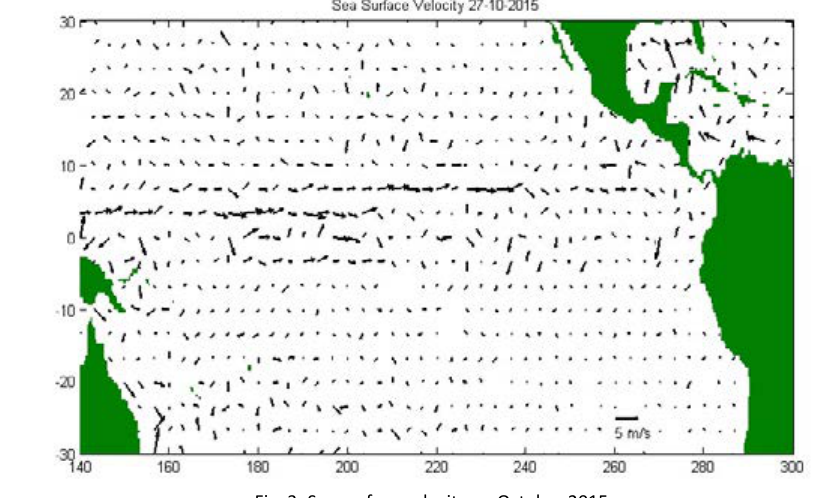
Fig. 3 : Sea surface velocity on October 2015